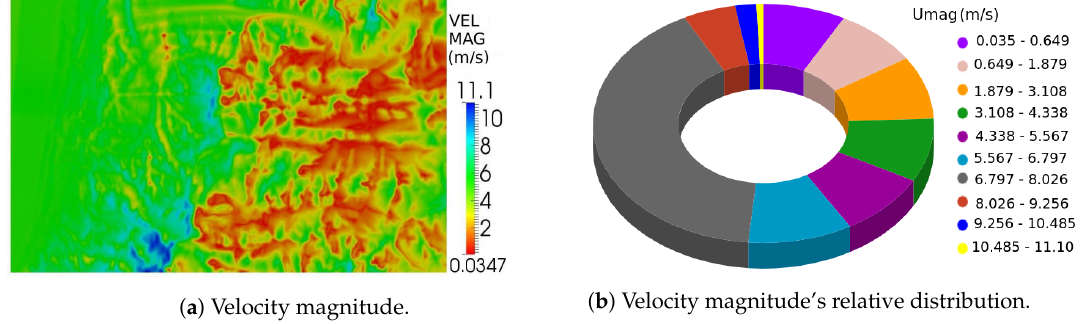
Figure 10. Velocity magnitude at 30 m.